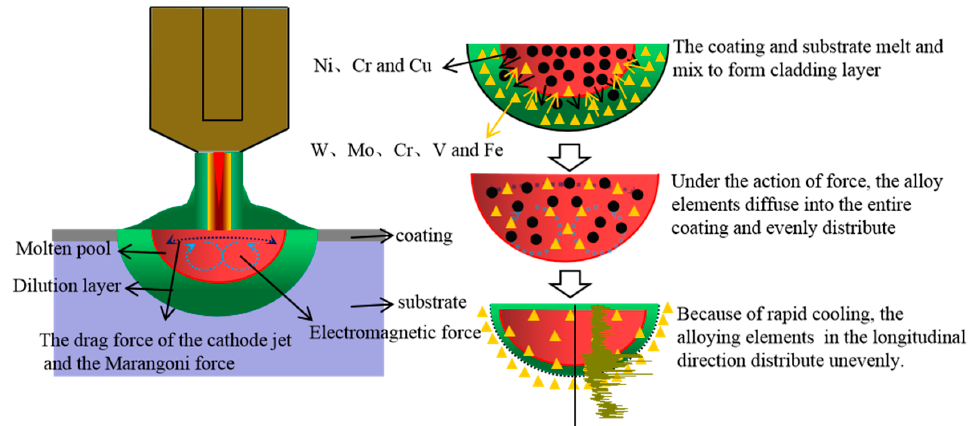
Figure 12. Schematic diagram of redistribution of elements.